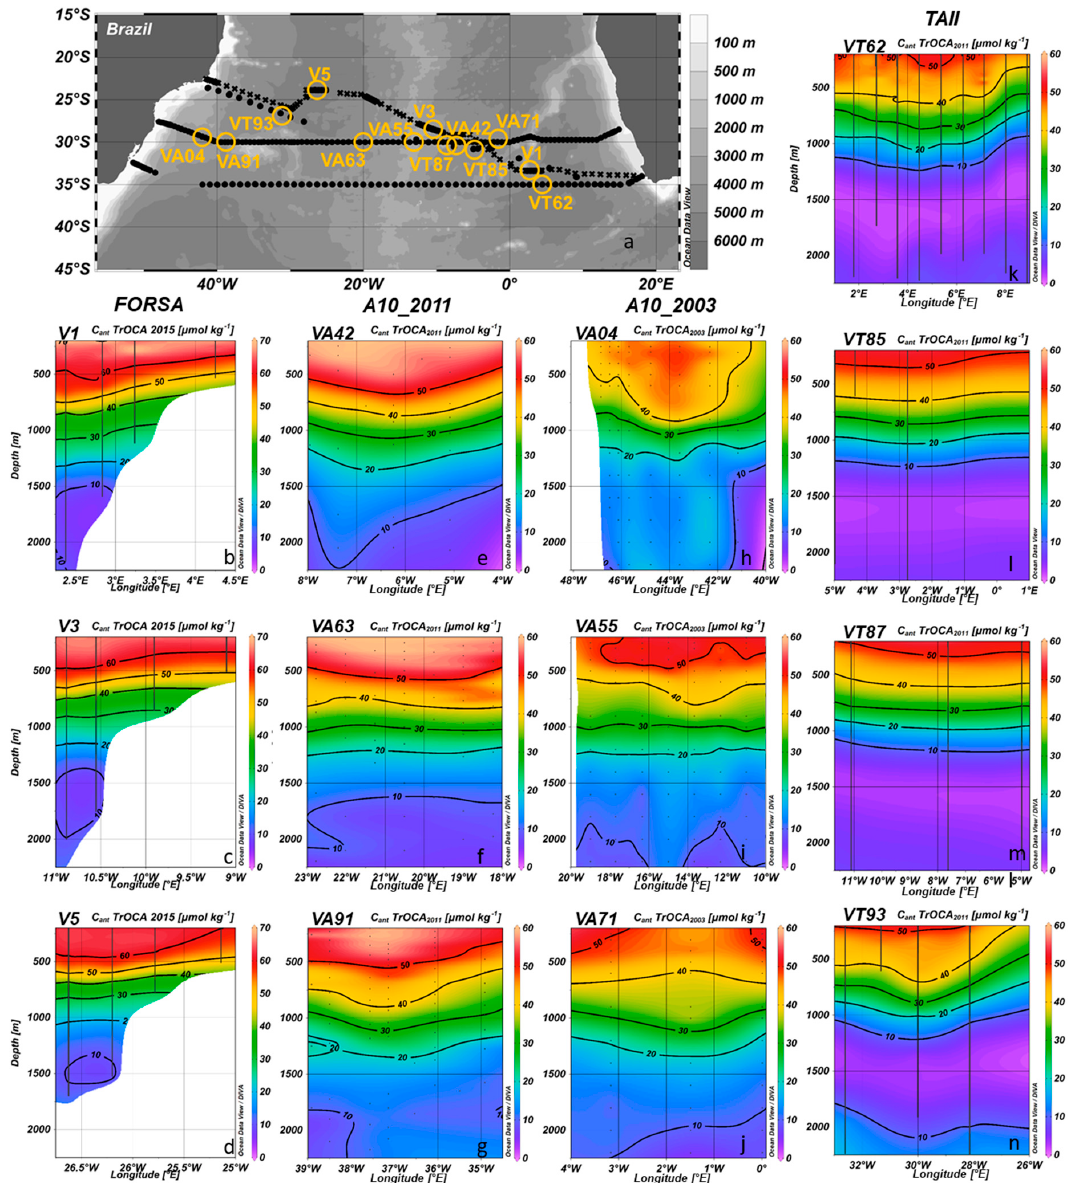
Figure 8. ( a ) Map of the cruise sections and sampled eddies. For a complete description of this map,